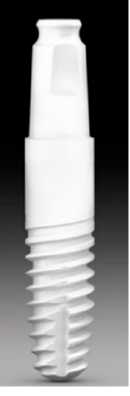
Figure 1. whiteSKY zirconia implant (Bredent GmbH& Co. KG) Adapted from: https://www.bredent.co.uk/products/sky-implants (accessed on 15 October 2021).